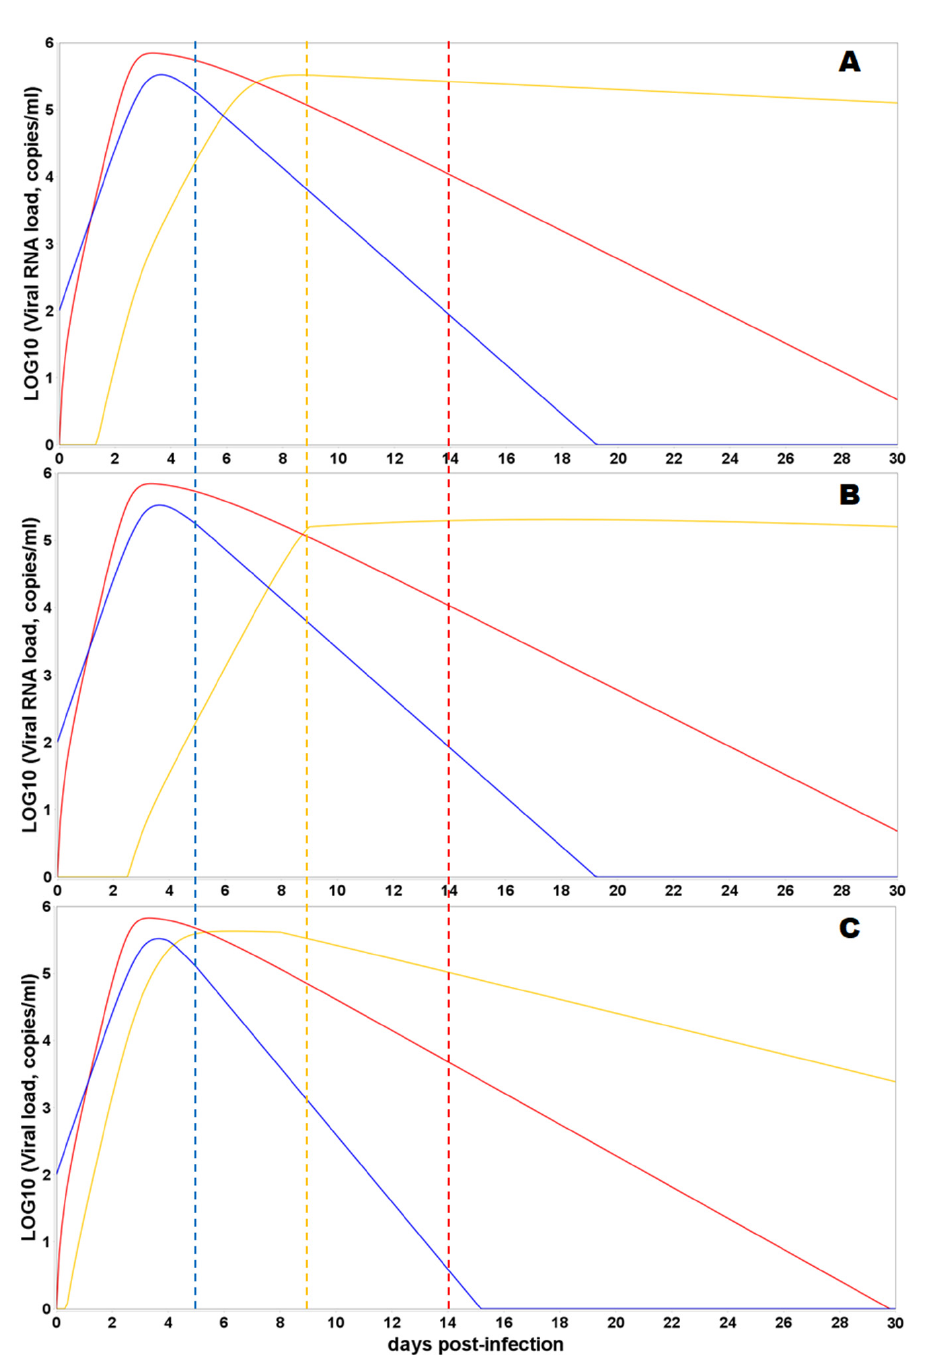
Figure 4. Predicted viral load trajectories in the nasopharyngeal region (NP, blue curve), gastrointestinal tract (intestine, red curve), and lungs (lung, orange curve) are shown. The dashed vertical lines correspond to the timing of humoral immune response initiation in a certain compartment (the color of the dotted line corresponds to the color of the viral trajectory in the compartment). The initial viral load is 100 viral particles in the NP. Y -axis—log10 of viral load (copies/mL); X -axis—days from the moment of infection. ( A ) Values of the transport parameters correspond to the default values from Table 1. ( B ) Values of the transport parameters from the nasopharyngeal region to the lungs and from the intestine to the lung were reduced 100 times. ( C ) Values of the transport parameters from the nasopharyngeal region to the lungs and from the intestine to the lung were increased 100 times.